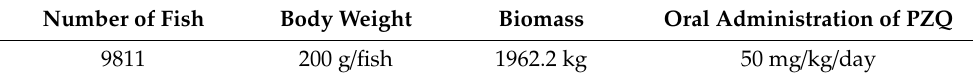
Table 4. Oral administration of PZQ in the monitored net